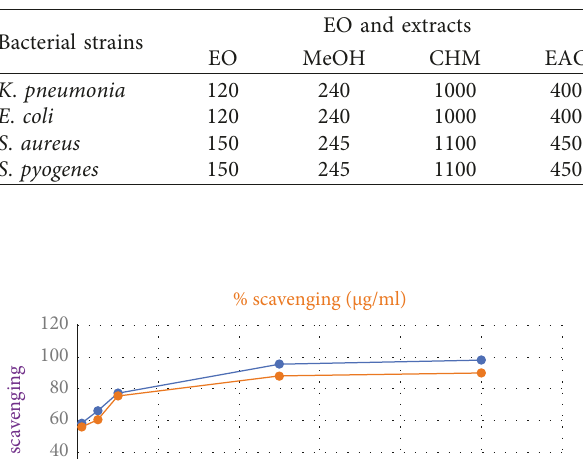
Table 6: Minimum inhibitory concentration in μ g/ml of the plant EO and extracts against bacterial strains.